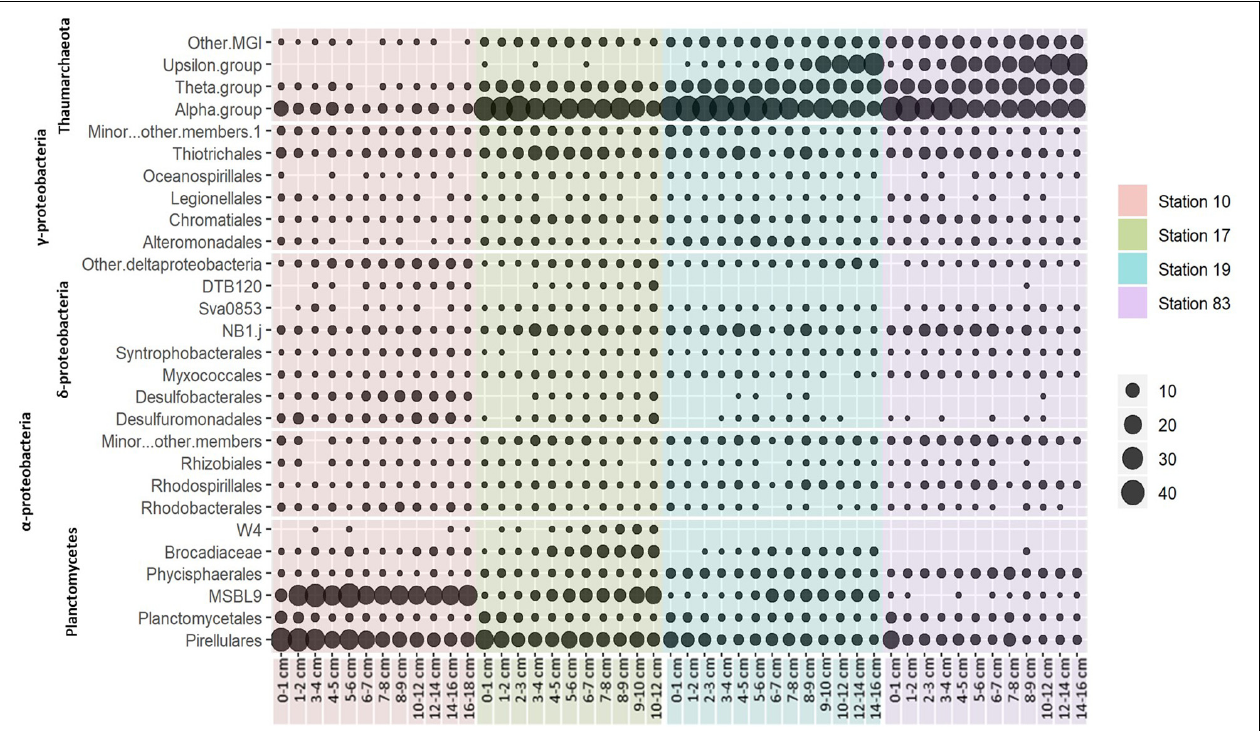
FIGURE 4 | Phylogenetic distribution of major microbial 16S rRNA gene OTUs based on a 97% similarity cut-off. Circle size indicates the relative abundance of the clade based on order